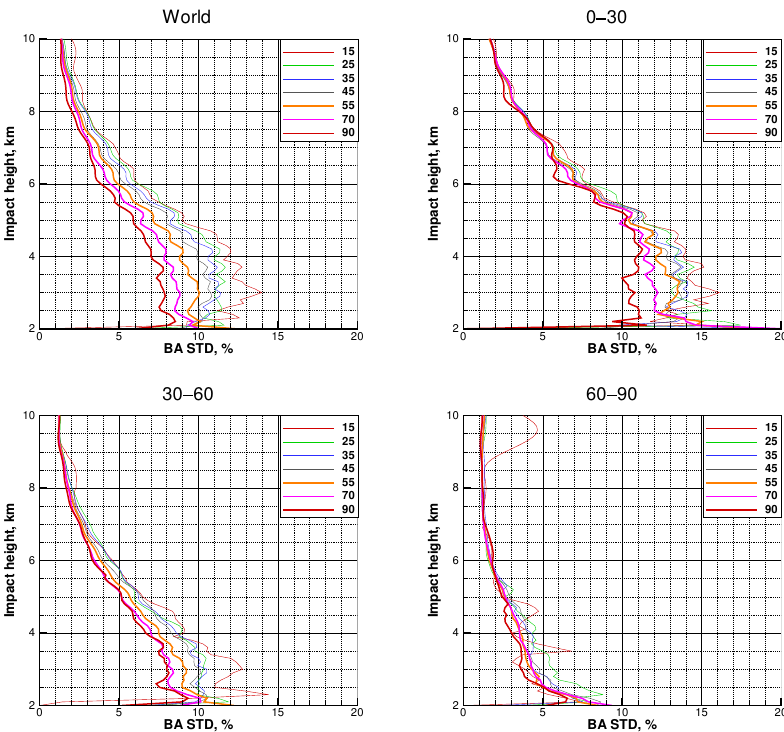
Figure 3. Similar to Figure 2. COSMIC, standard deviation.